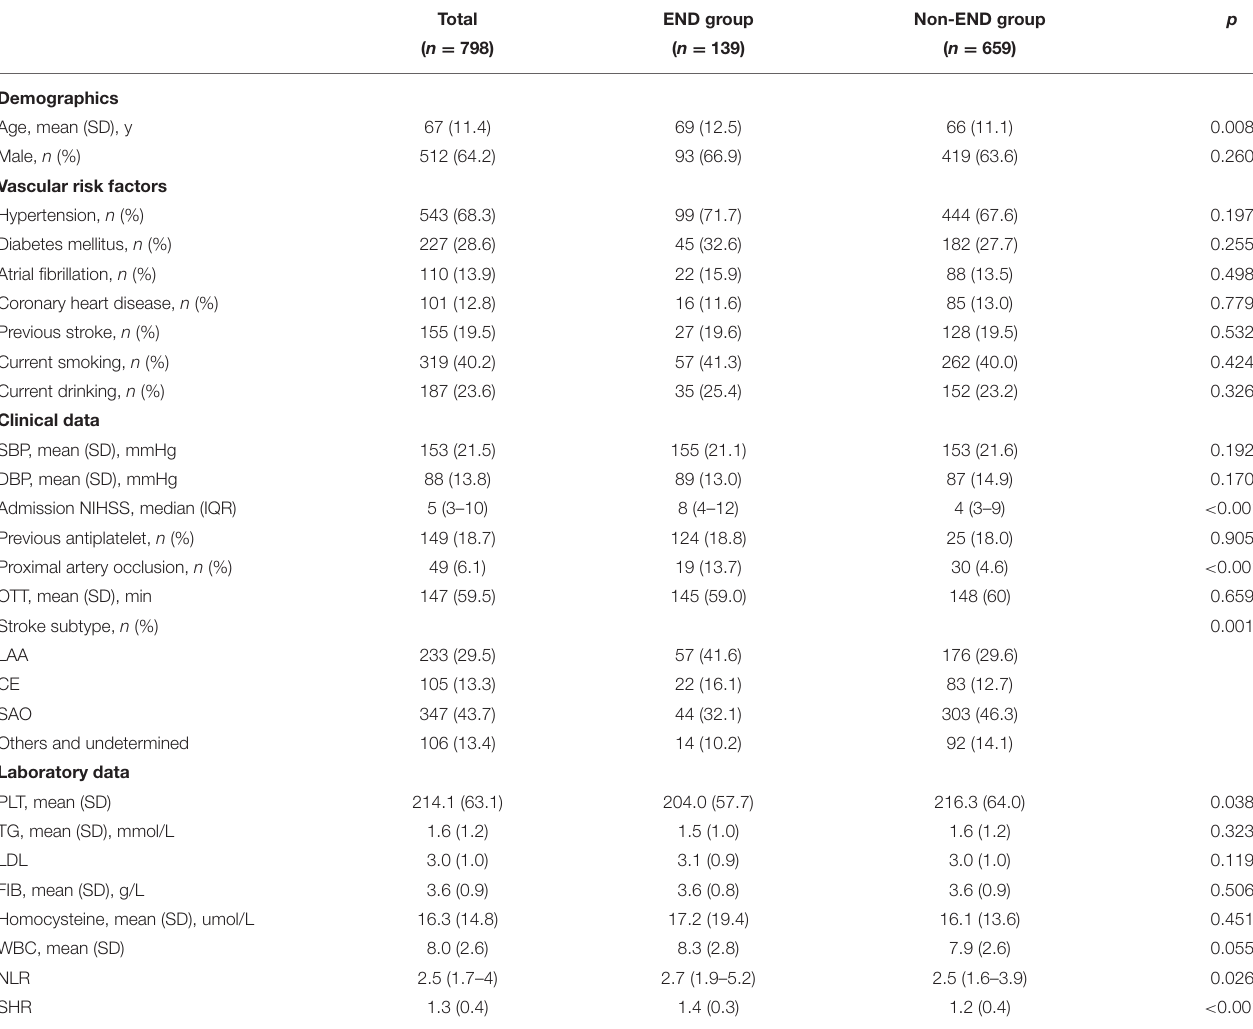
TABLE 1 | Baseline characteristics of subgroups based on the presence of post-thrombolysis early neurological